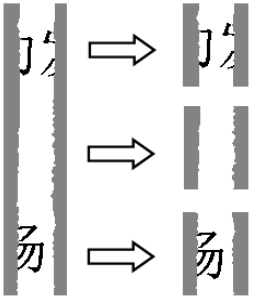
Figure 2. Piece divided into a series of blocks.